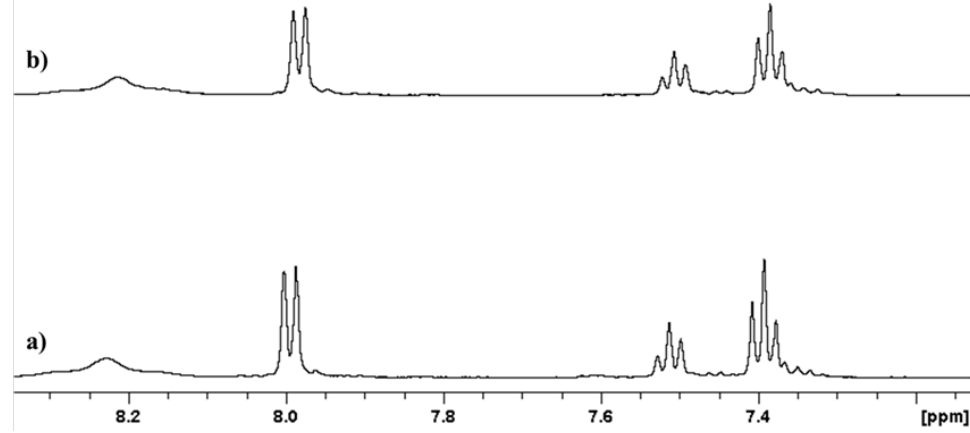
Figure 3. Portion of the 1 H-NMR (500 MHz) spectra of compound 1 in Acetone-d 6 /D 2 O before ( a ) and soon after ( b ) addition of DCl (pH = 1.5).